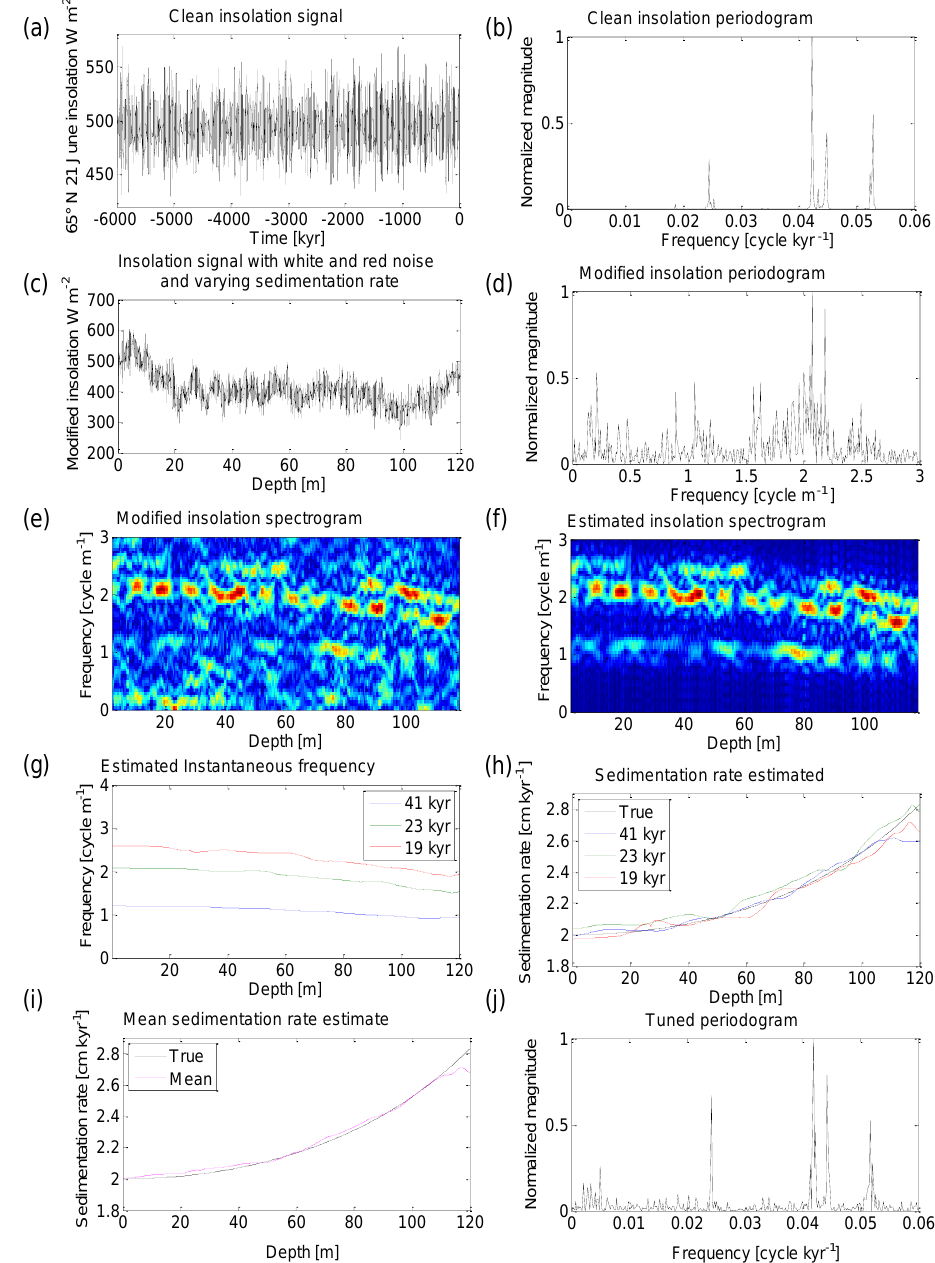
Figure 2. ACE v.1 analysis for a synthetic insolation signal. (a) 6Ma insolation for 65 ◦ N 21 June (Wm − 2 ) (Laskar et al., 2004). (b) The periodogram of the clean insolation signal as plotted in Fig. 2a. (c) To make the conversion from the distance towards the time domain a constant sedimentation rate of 2cmkyr − 1 is used. Using linear interpolation a non-constant sedimentation rate is mimicked. The changing sedimentation rates are plotted in Fig. 2h–i. Additional white and red noise are added to the signal as discussed in the text. (d) The peri- odogram of the modified insolation signal as plotted in Fig. 2c, which is noisier than the original periodogram (Fig. 2b) because of the added perturbations. (e) The spectrogram of the modified insolation signal. (f) The spectrogram of the three modeled components (41kyr obliq- uity, 23kyr precession and 19kyr precession) using ACE v.1. (g) Estimated instantaneous frequencies for the three modeled components. (h) Using the associated astronomical periods of the modeled frequencies, the corresponding sedimentation rate is calculated and compared with the initial input change in sedimentation rate. (i) Comparison between the initial input change in sedimentation rate and the mean of the modeled components. (j) Periodogram of time series of the signal where the mean sedimentation rate estimate is used to make the conversion to the time